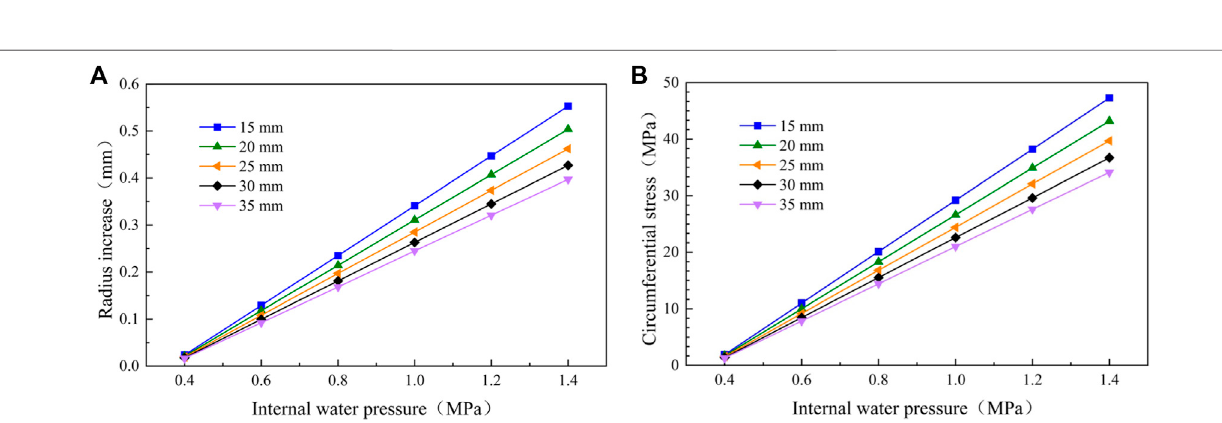
Frontiers in Earth Science |